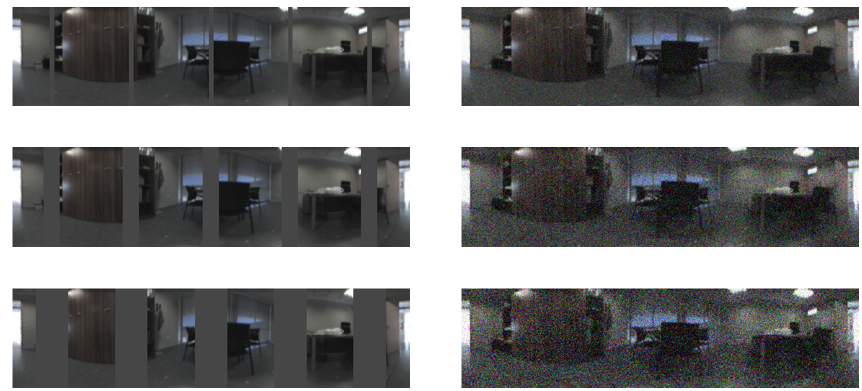
Figure 14. Some examples of test images with different artificial occlusion percentage and with added Gaussian noise with different